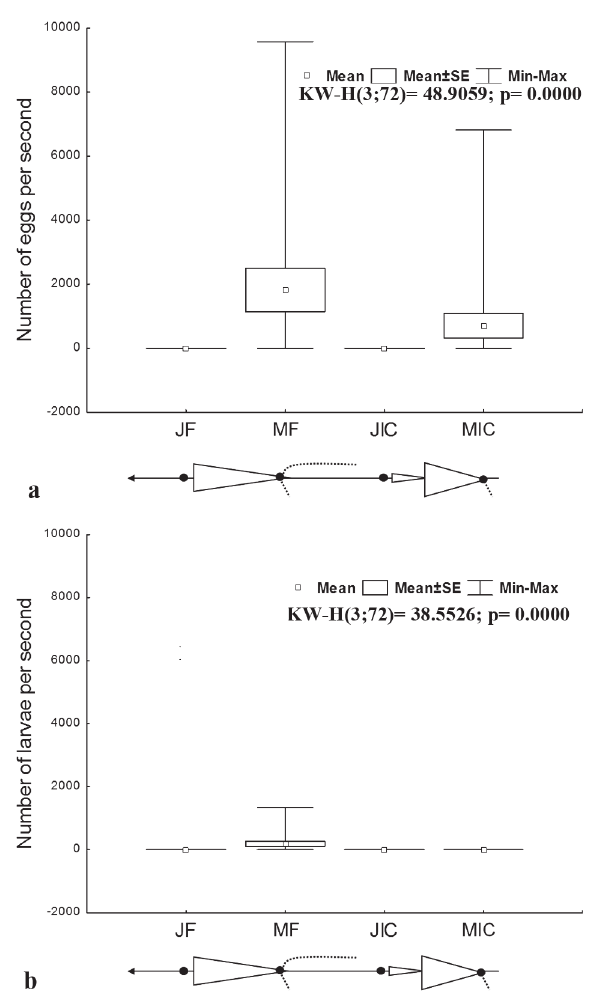
Fig. 2. Box plot of the number of eggs ( a ) and larvae ( b ) per second reaching the upstream and downstream regions of the Funil and Itutinga-Camargos Reservoirs from November 2008 to March 2009. Small open dots represent the tributaries sampled; triangles represent the reservoirs; black dots represent sites where numbers of eggs and larvae were estimated; and arrows represent the direction of flow (JF = downstream of the Funil Dam; MF = upstream of the Funil Reservoir; JIC = downstream of the Itutinga-Camargos Dam; and MIC = upstream of the Itutinga-Camargos Reservoir).